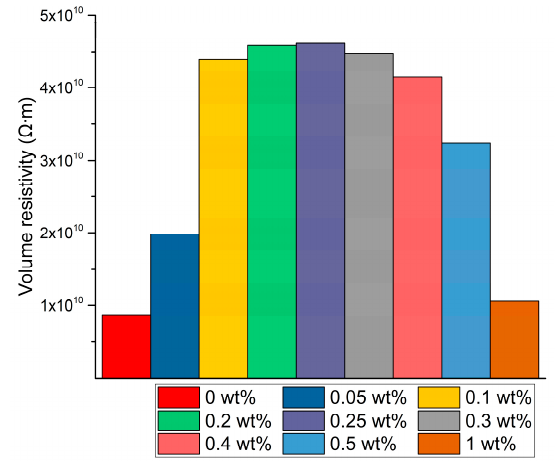
Figure 10. Dependence of the volume resistivity of nanofluids with ST TiO 2 on nanoparticle concentration, 90 °C.